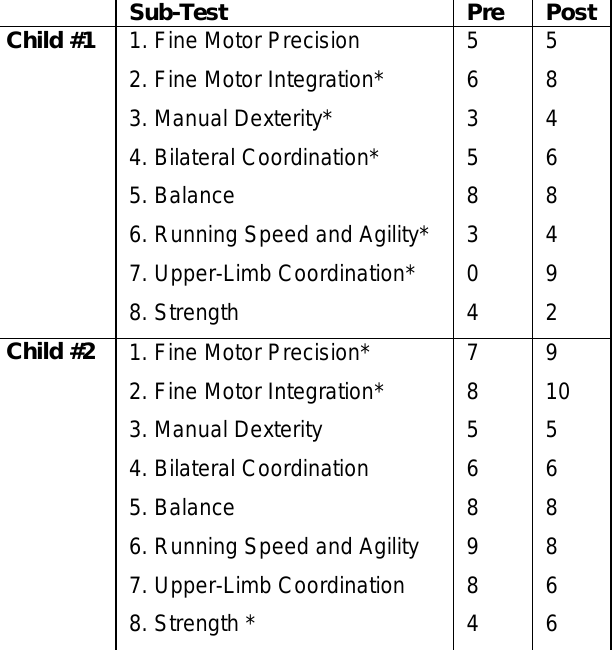
Table 3. The Bruininks-Oseretsky Test of Motor Proficiency Short Form (BOT2-SF) Detailed Sub-Scores